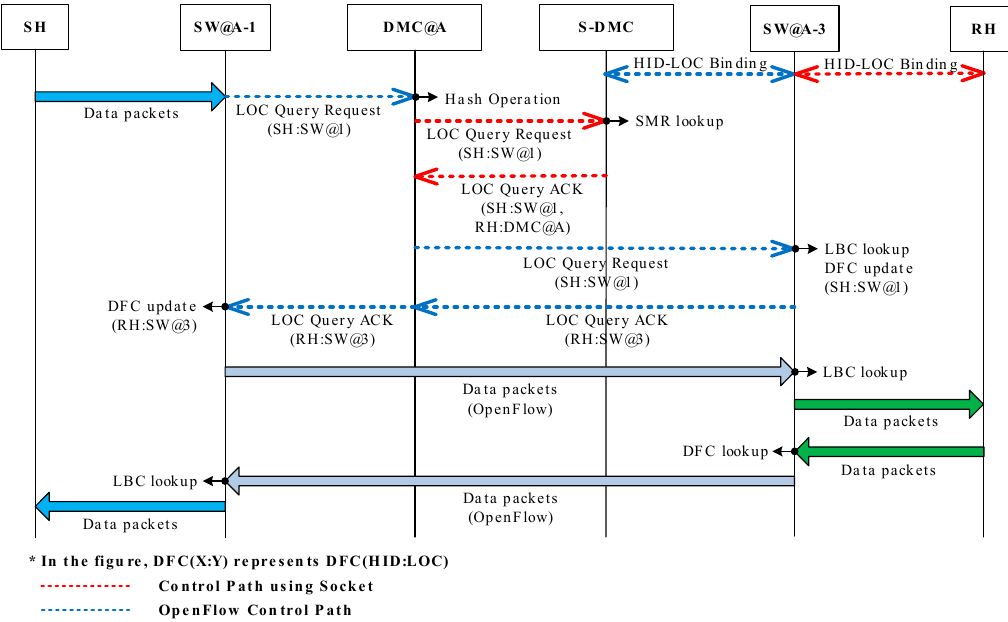
Figure 4. HID–LOC binding operations.